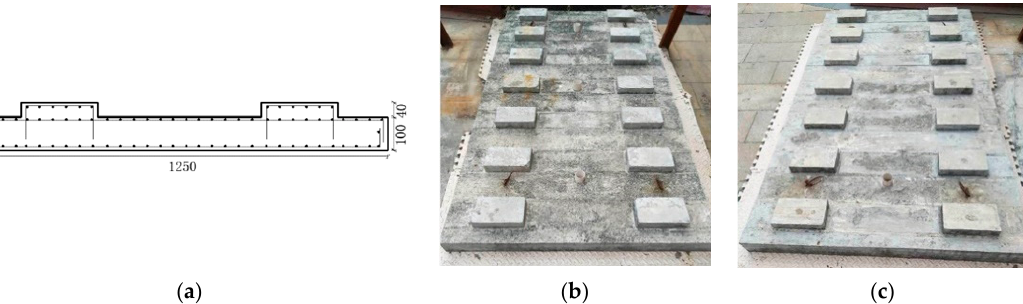
Figure 4. ( a ) Reinforcing bar setting; ( b ) Casting processing; ( c ) Casted slab track plate.